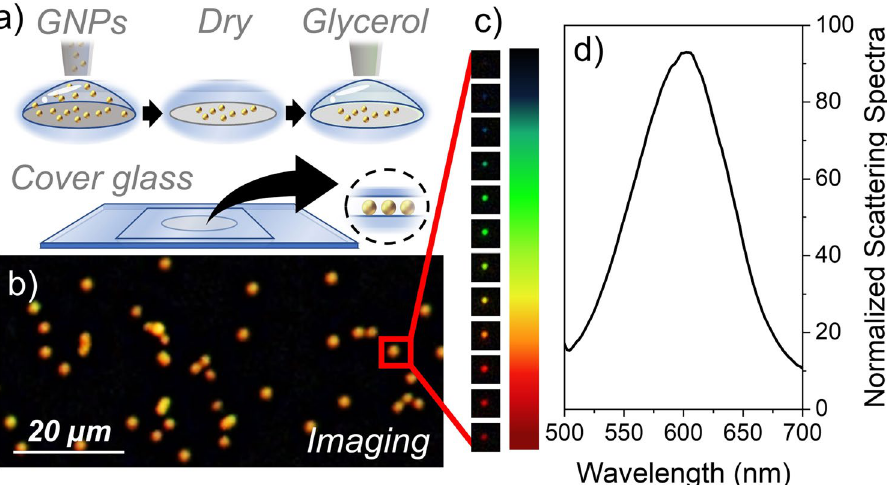
Figure 2. ( a ) Schematic drawing of the sample preparation. Nanoparticles are deposited onto a glass slide and then dried. Before adding a glass coverslip on top, a drop of glycerol is added to the dried nanoparticles. ( b ) Cropped dark-field image of nanoparticles deposited onto a transparent glass substrate; the image has been captured with the diascopic illuminator of the microscope in transmission mode. ( c ) Cropped dark-field image of a single nanoparticle taken at different wavelengths of the visible spectrum. ( d ) Scattering spectra of the nanoparticle identified by the red rectangular inset shown in ( b ); it has been normalized to the scattering signal coming from the